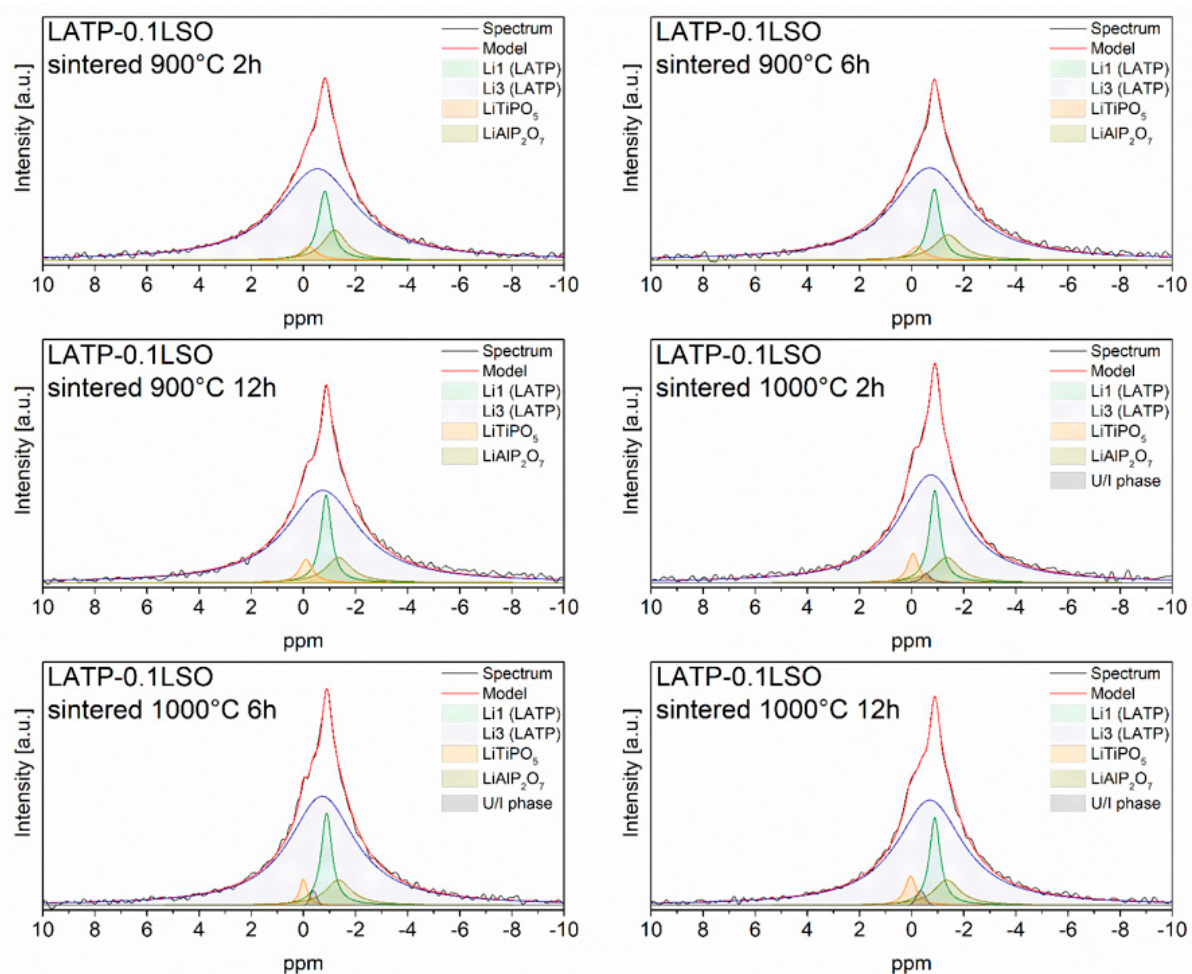
Figure 6. 6 Li NMR spectra of LATP–0.1LSO sintered at 900 and 1000 ◦ C for 2, 6, or 12 h. The experimental and simulated spectra are displayed as black and red lines, respectively. The simulated spectra are the sum of distinct line-shapes displayed with different colors.